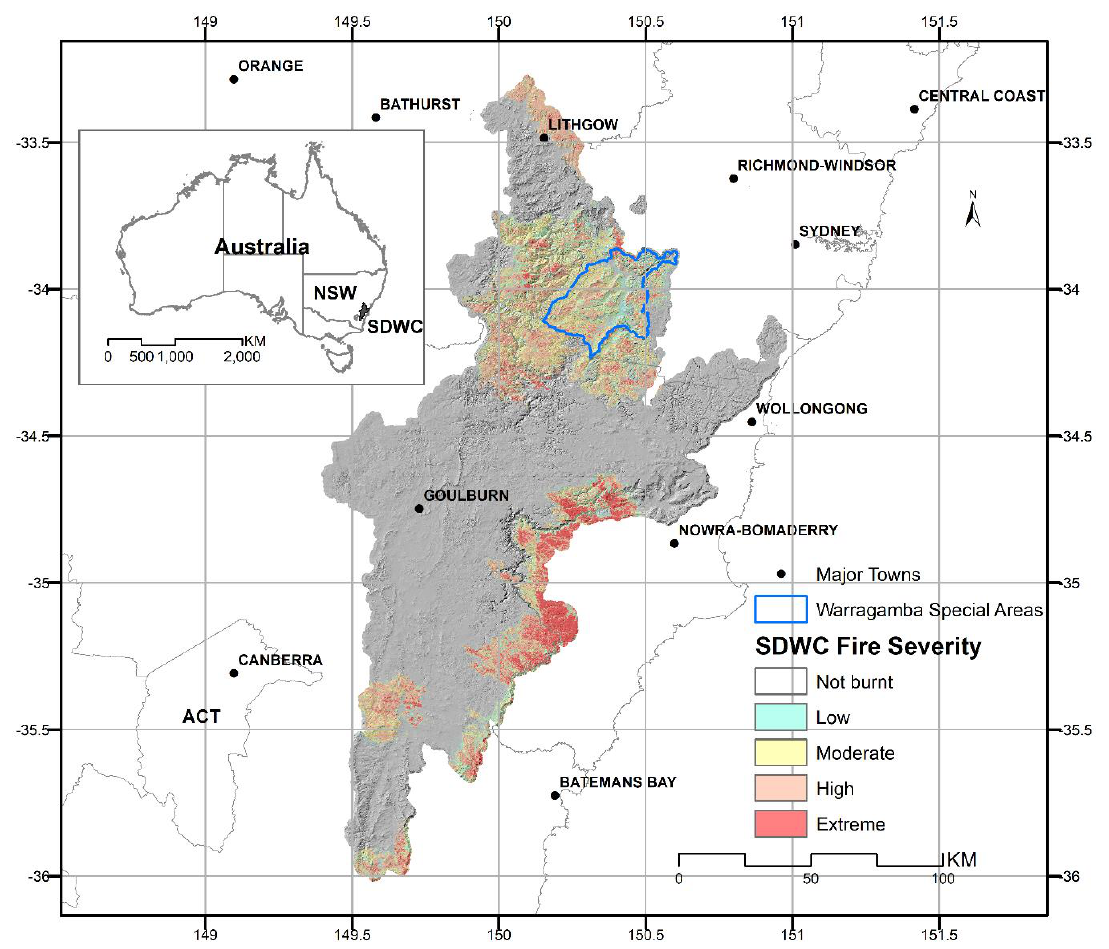
Figure 1. Location of the Sydney drinking water catchment area and the Warragamba Dam (Lake Burragorang) Special Areas with fire severities, New South Wales (NSW), Australia. The background map is the hill-shaded elevation from the 5 m digital elevation model.